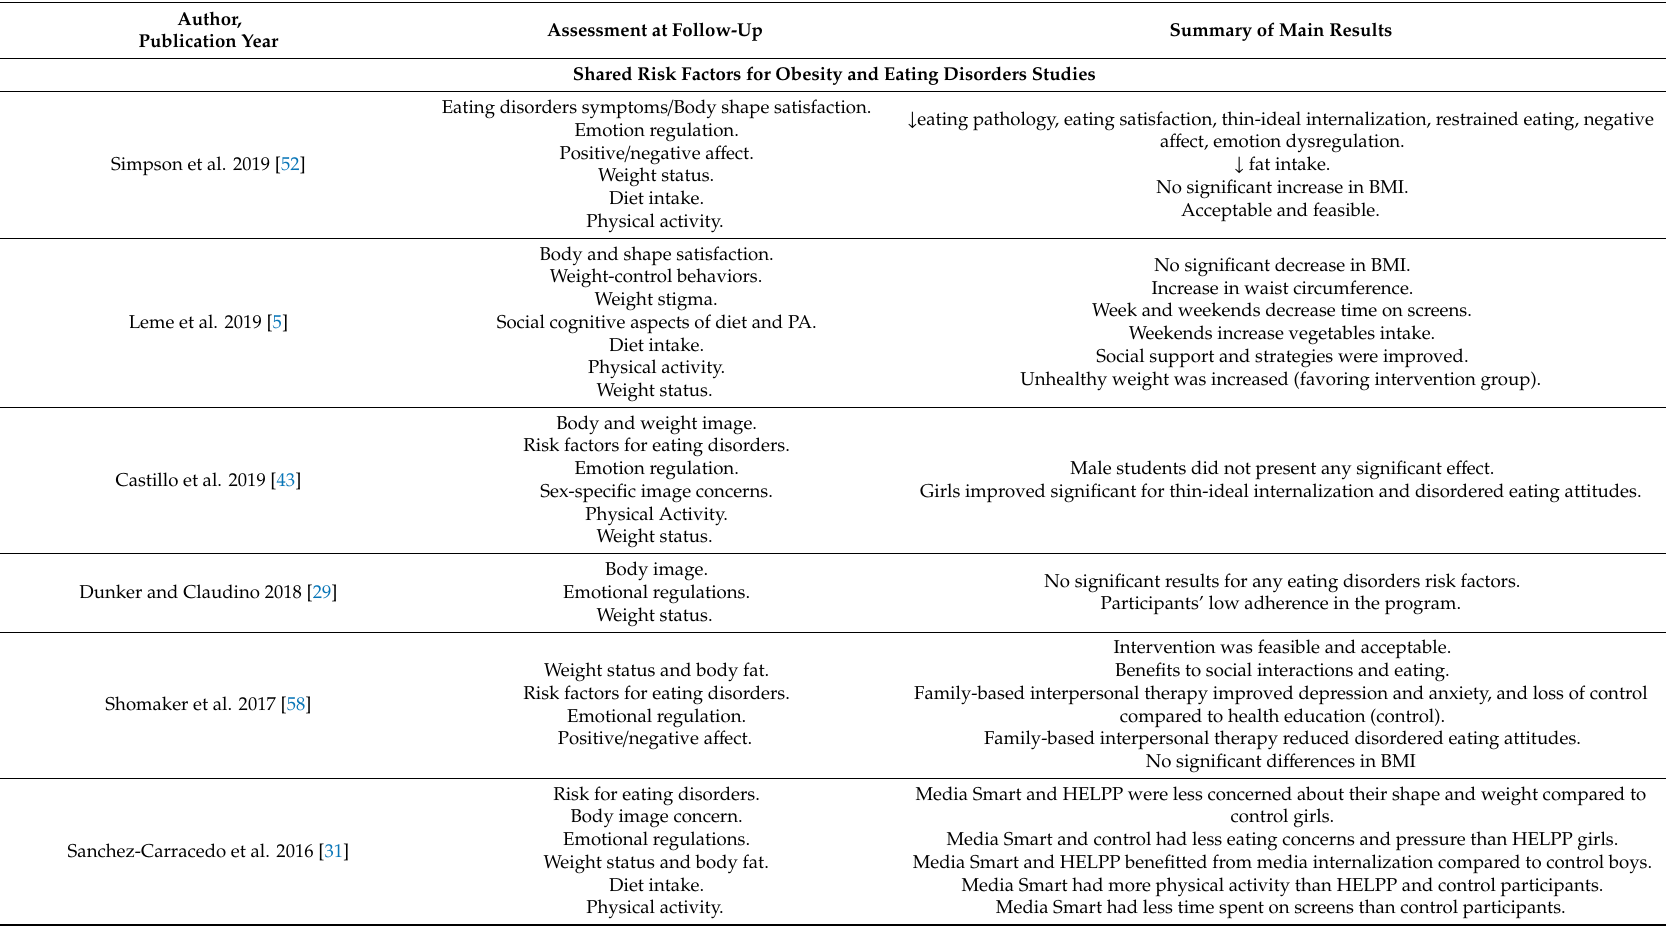
Table 2. Findings from the intervention